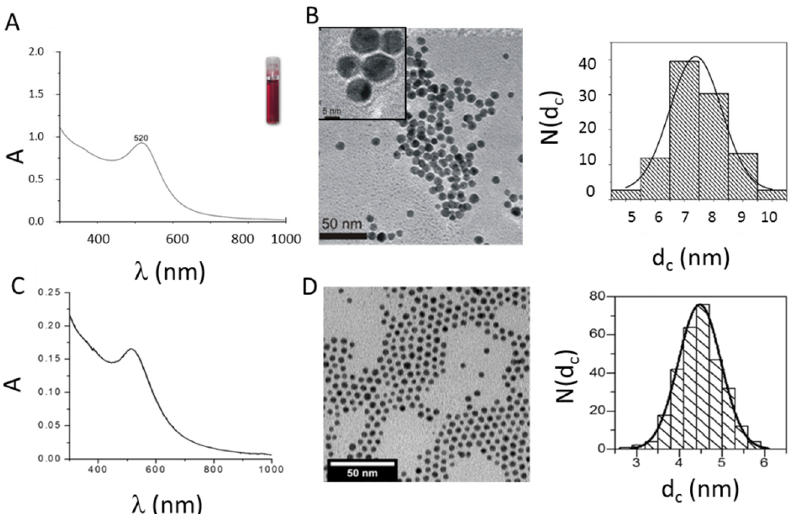
Figure 1. ( A ) UV-VIS absorption spectrum A ( λ ) of collagen-coated gold nanoparticles (Au NPs). The inset shows a vial with a solution of the Au NPs in water. ( B ) Transmission electron microscopy (TEM) images and size distribution of collagen-coated Au NPs. The scale bar in the inset corresponds to 5 nm and the scale bar in the main image to 50 nm. From the size distribution N ( d c ) of the inorganic cores, as seen in the TEM image, the mean value ± the standard deviation was determined to be d c = 7.4 ± 2.4 nm. N corresponds to the number of counted NPs. ( C ) UV-VIS absorption spectrum A ( λ ) of PMA-coated Au NPs in water. ( D ) TEM images and size distribution N ( d c ) of PMA-coated Au NPs. The scale bar corresponds to 50 nm. As a result, d c = 4.4 ± 1.1 nm was